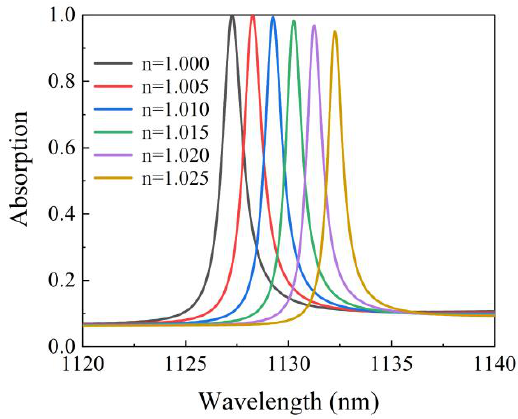
Figure 11. Absorption spectrum as a function of the refractive index of the background.